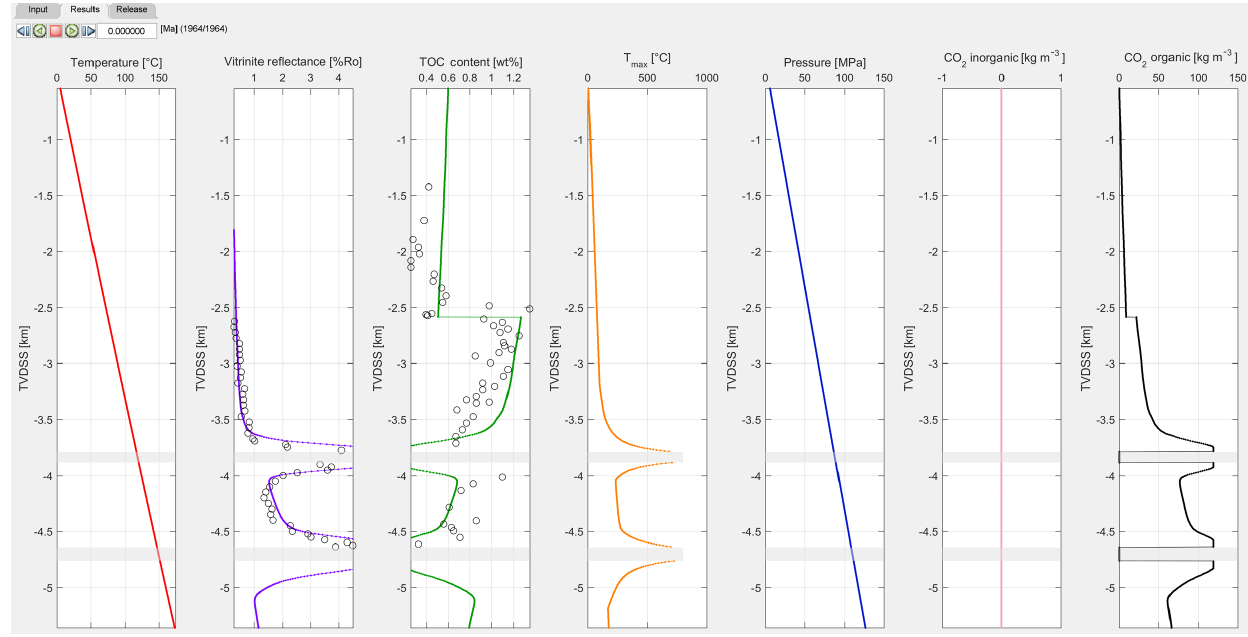
Figure 7. Results tab at the end of the simulation time for the Utgard High example. The present-day VR and TOC values (circles) show a good match with the model